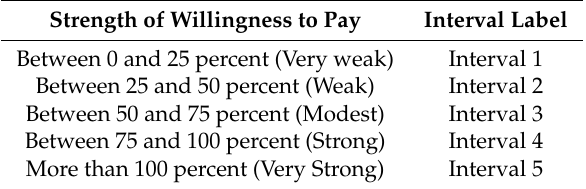
Table 2. Strength of willingness to pay for broilers produced by high welfare